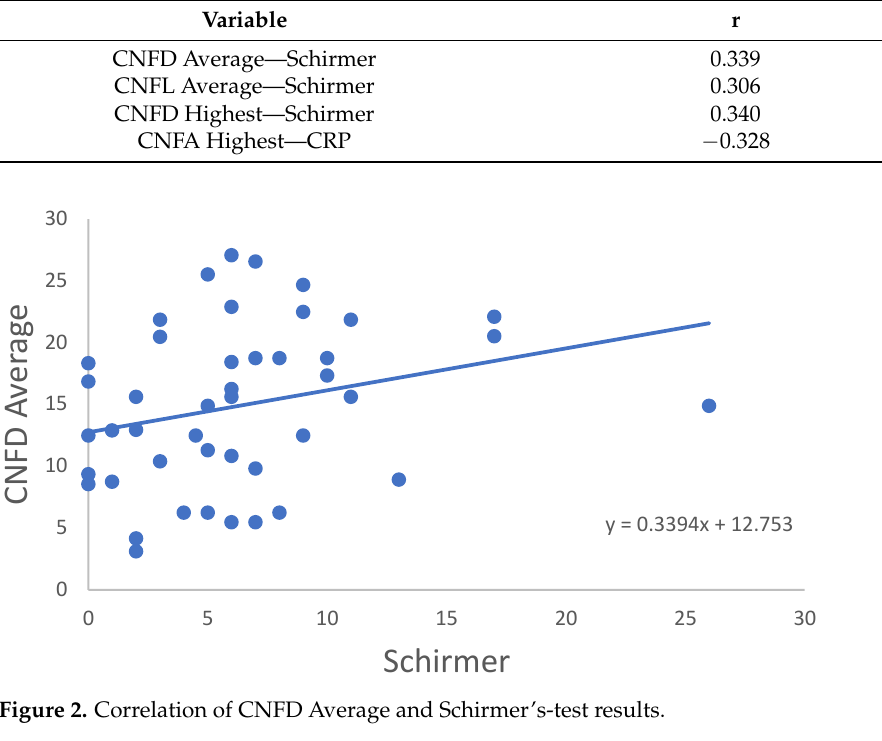
Figure 2. Correlation of CNFD Average and Schirmer’s-test results.